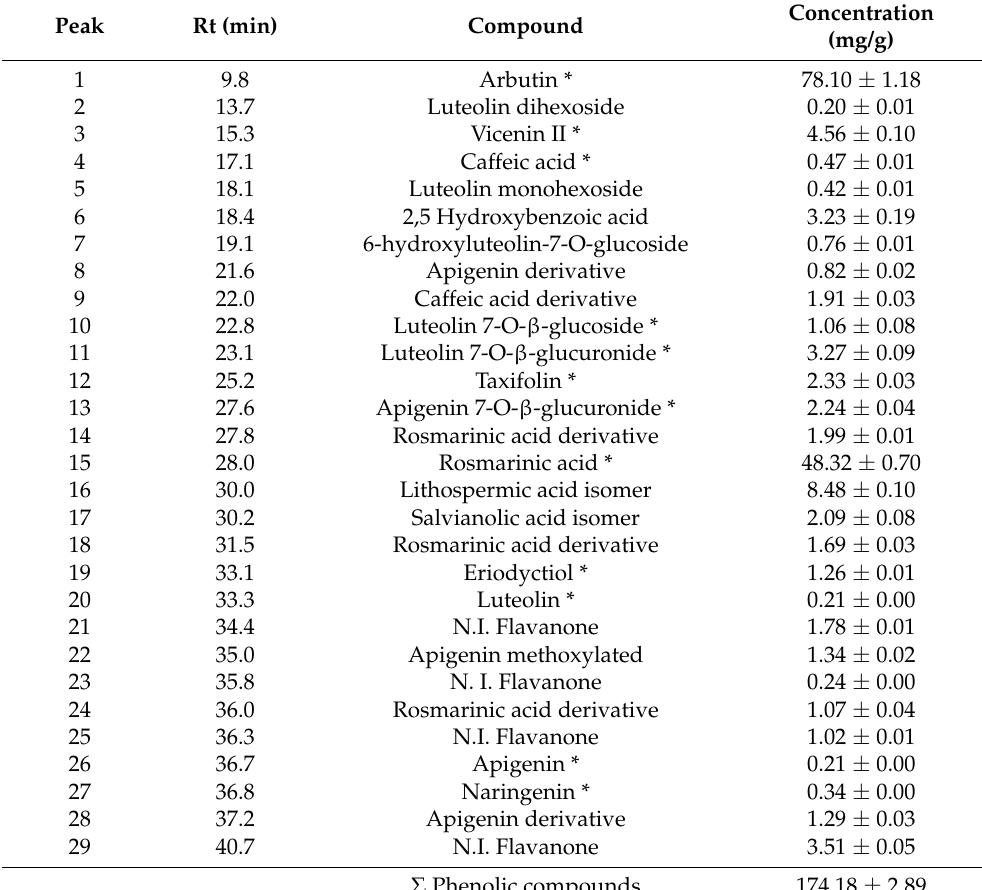
Table 1. Phenolic composition of UAE marjoram extract. Peak Rt (min) Compound